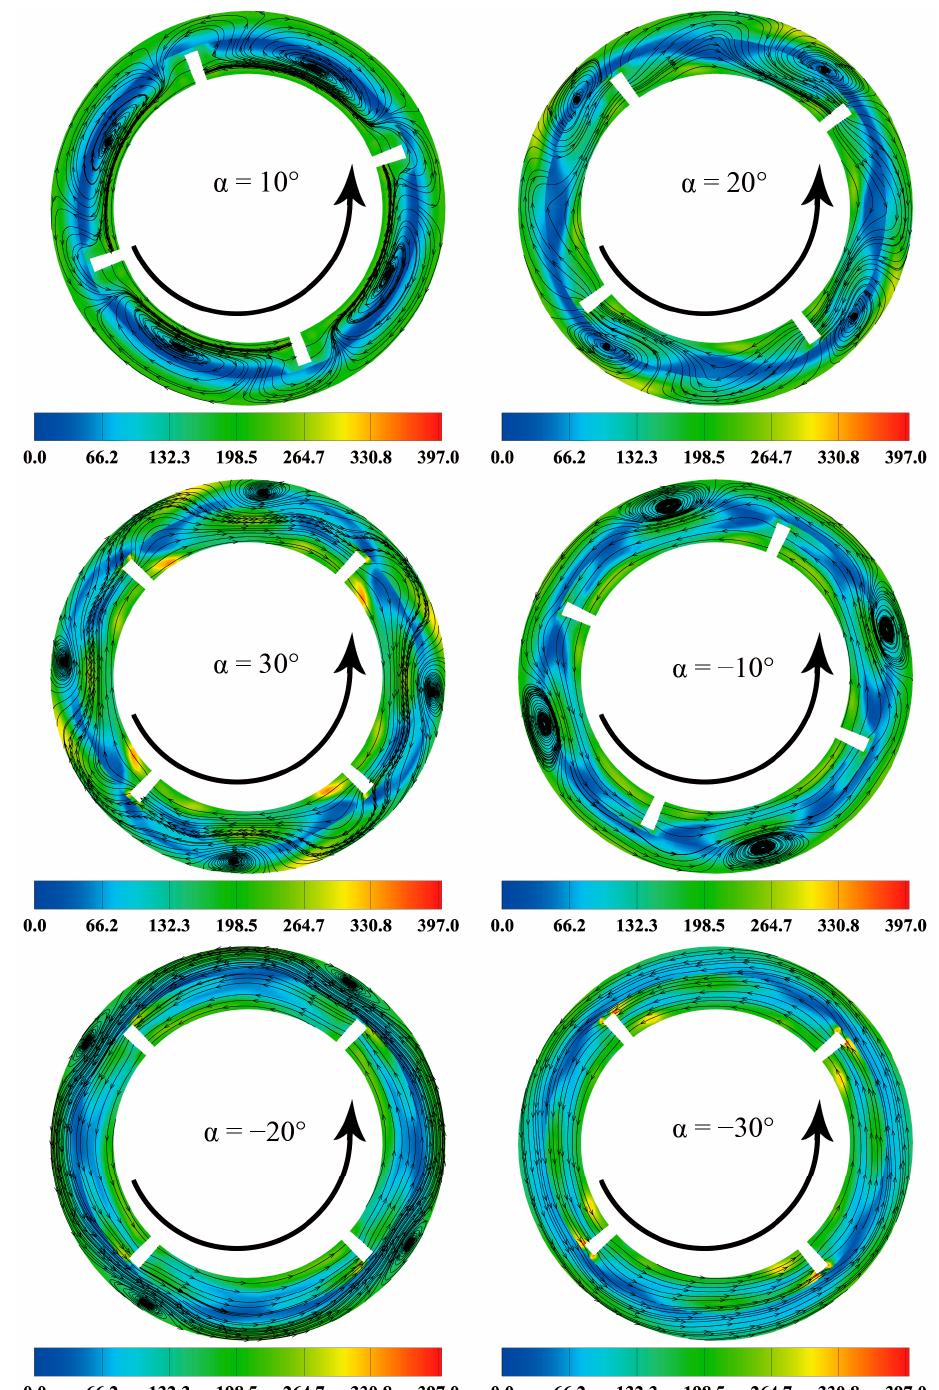
Figure 12. Vorticity distribution and the stream traces at the end cross-section of the straight blade with different helical angles.